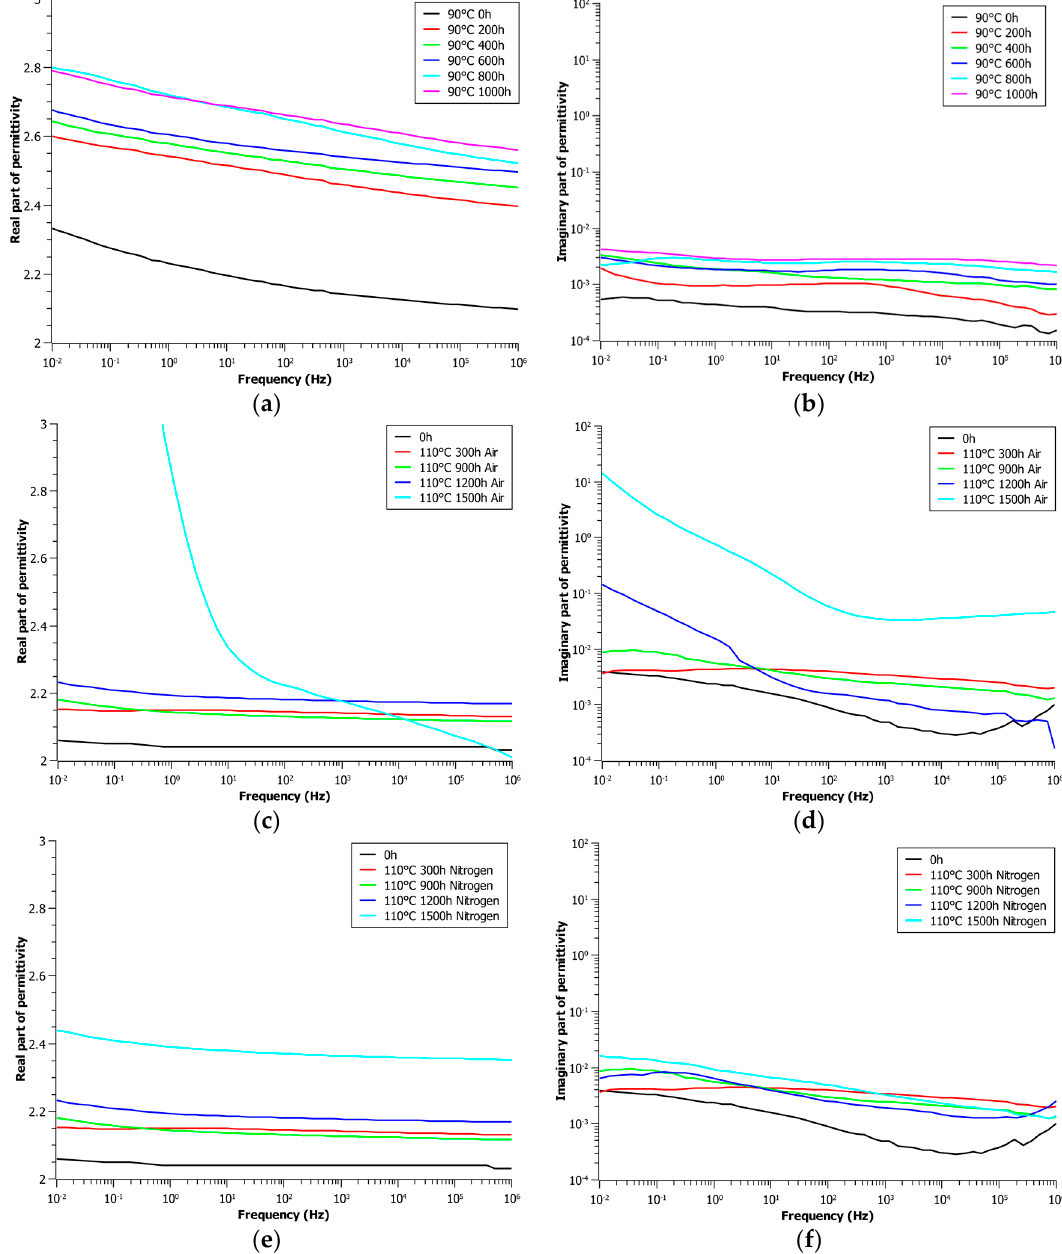
Figure 1. Real ( a , c , e ) and imaginary ( b , d , f ) part of permittivity as a function of the frequencies and aging times of 90 °C in air, 110 °C in air, and in nitrogen aging, respectively.